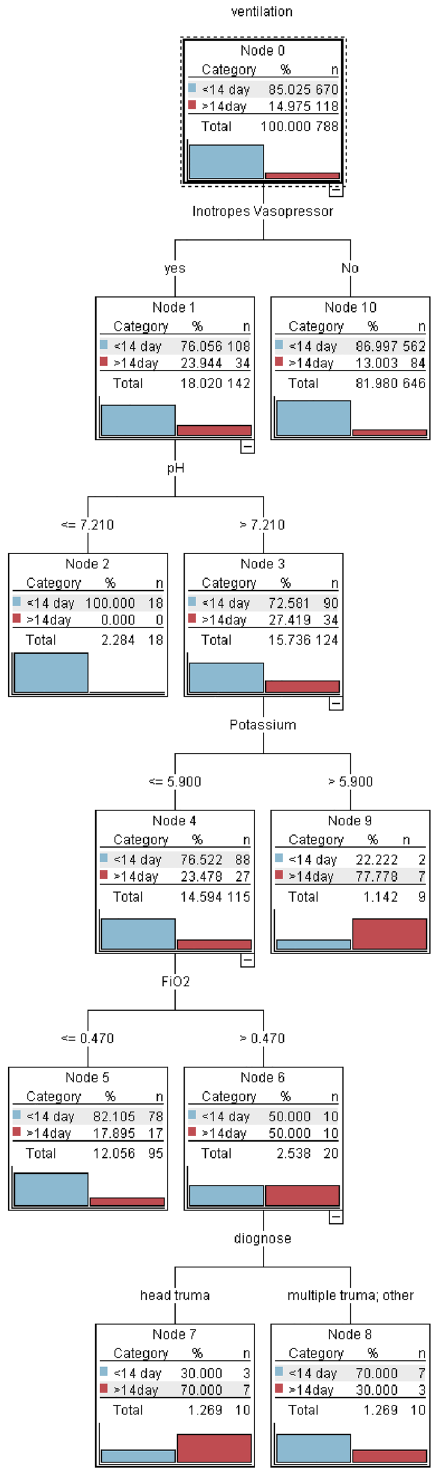
Figure 2. Decision tree for predicting prolonged mechanical ventilation in the intensive care unit. potential of hydrogen (pH), Fraction of inspired oxygen (FiO 2